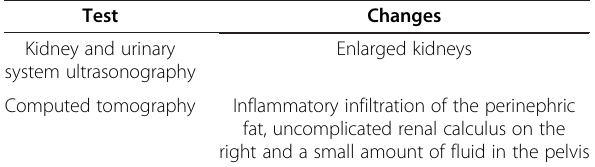
Table 2 Medical imaging tests Test Changes Kidney and urinary Enlarged kidneys system ultrasonography Computed tomography Inflammatory infiltration of the perinephric fat, uncomplicated renal calculus on the right and a small amount of fluid in the pelvis Source: patient ’ s